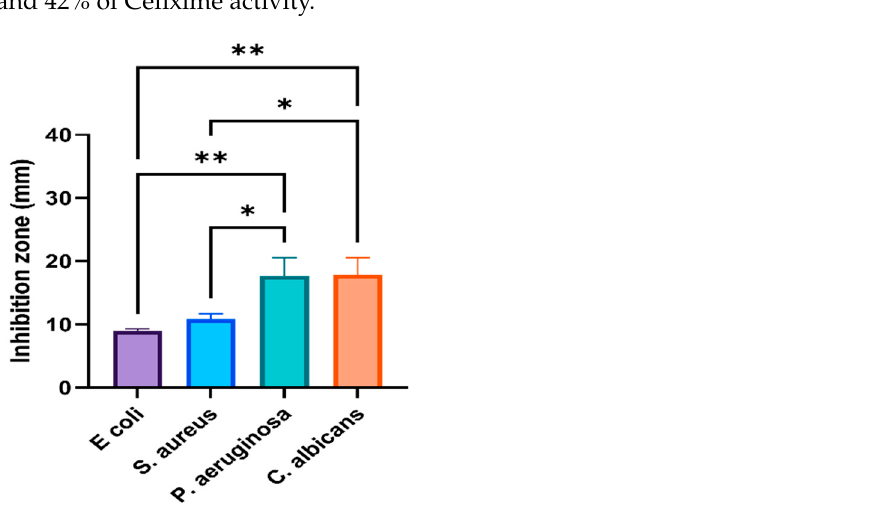
Figure 8. Activity of AgNO 3 against tested microbes. One-way ANOVA with was performed to identify differences between groups. p < 0.01 (**), p < 0.05